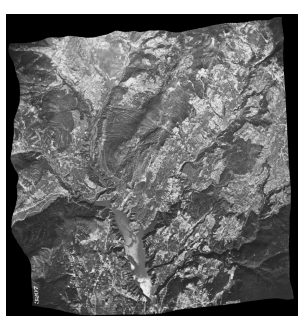
Figure 4. Ortho-photo from the 1954